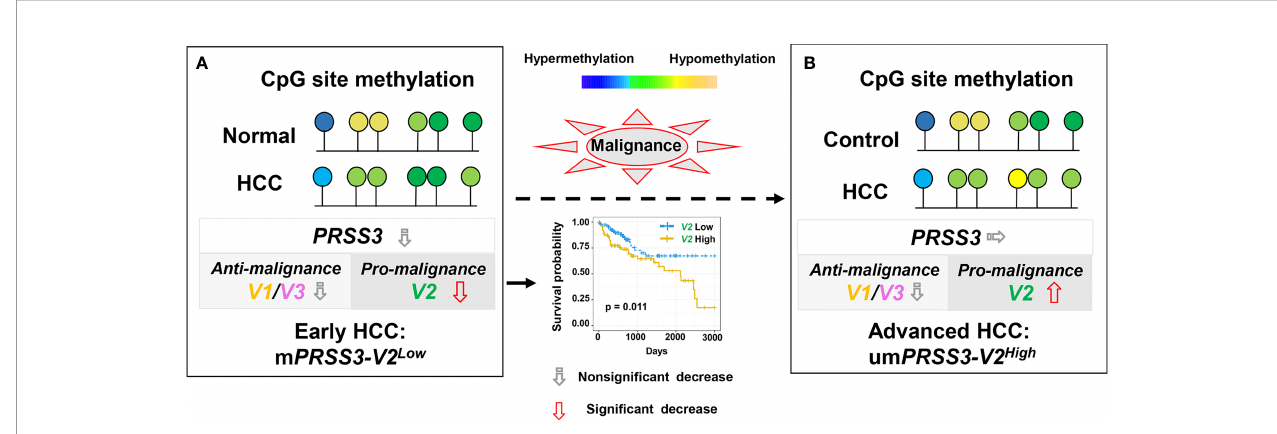
FIGURE 7 | A schematic model for epigenetic dysregulation of PPRSS3 transcripts functionally contributing to hepatocarcinogenesis and its biomarker potential. (A) Epigenetic silencing of PRSS3-SVs by site-speci fi c CpG methylation in the tumors of patients with early HCC, in which m PRSS3 Low was a potential biomarker favorable for patient survival. (B) Epigenetic disruption resulted in um PRSS3 High in tumors of advanced HCC